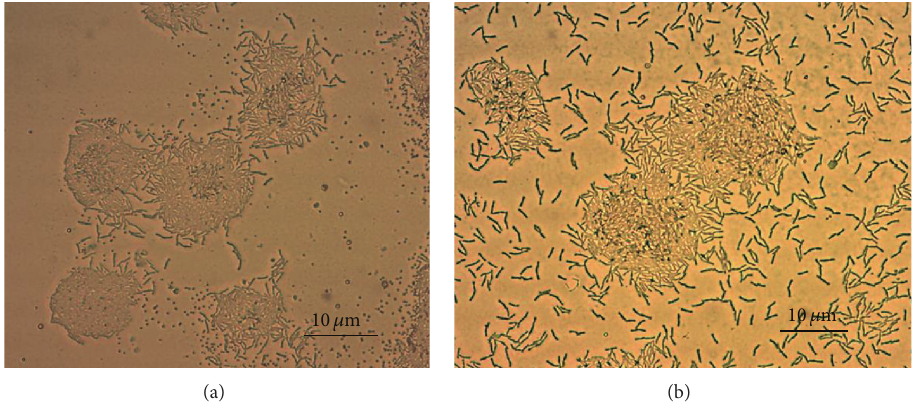
Figure 12: E. coli colonies growing on PVA hydrogel medium (a) and SA medium (b) after 6 h.